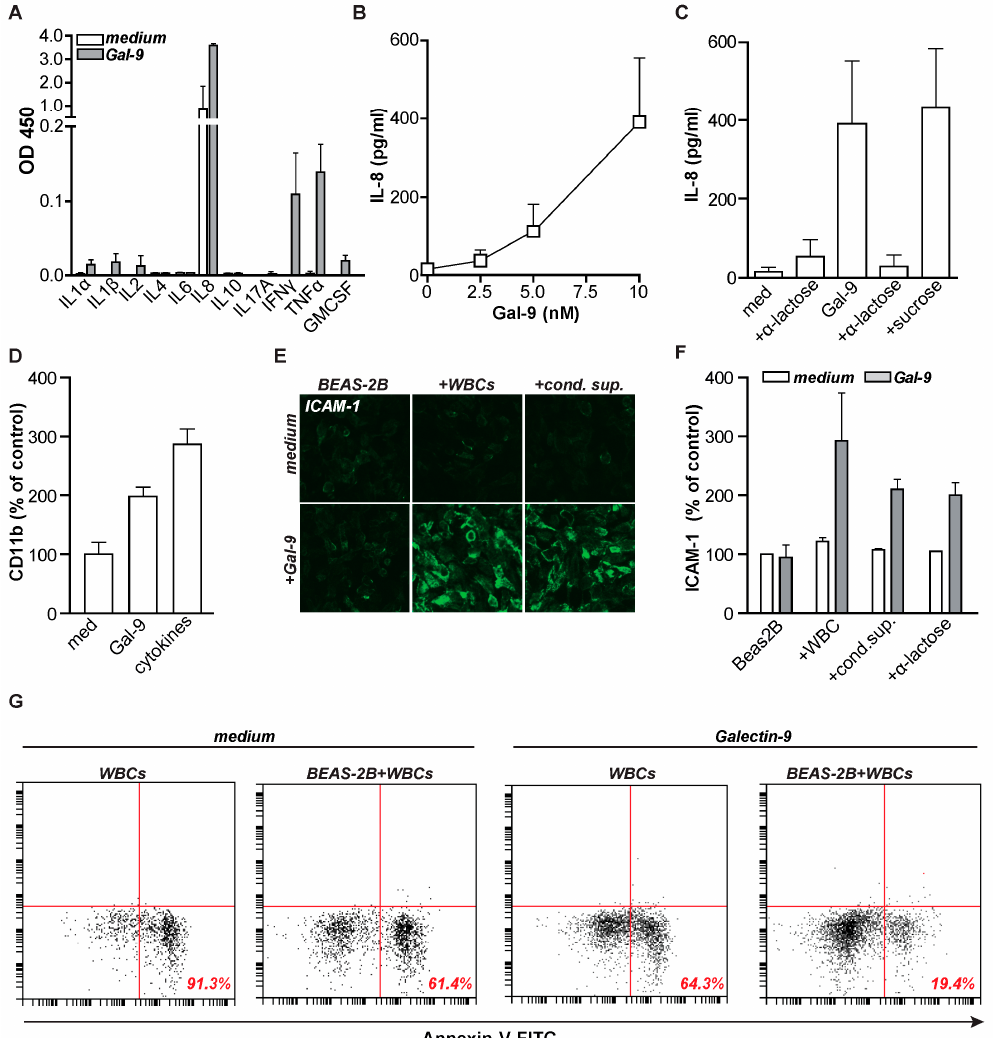
Figure 4. Gal-9 induces pro-inflammatory cytokines which induce Intercellular adhesion molecule 1 (ICAM-1) expression. ( A ) Screen for cytokines in supernatants of white blood cells (WBCs) after 16 h Gal-9 treatment (10 nM) using a multi-analyte ELISA. ( B ) IL-8 / CXCXL8 ELISA in the supernatants of WBCs treated with increasing concentrations of Gal-9. ( C ) ELISA to determine IL-8 concentrations in the supernatants of WBCs treated with 10 nM Gal-9 +/ − α -lactose (40 mM). ( D ) CD11b expression on granulocytes after 16 h Gal-9 treatment (10 nM) or a cytokine cocktail (400 pg / mL IL-8, 15 pg / mL TNF, 20 pg / mL IFN- γ ) containing the cytokines that are also induced by Gal-9 treatment. ( E ) Fluorescent pictures of ICAM-1 expression on Beas-2B cells after incubation with WBCs +/ − Gal-9 (10 nM) or conditioned supernatant harvested from medium- or Gal-9-treated WBCs. Magnification × 20 ( F ) As in ( E ), measuring ICAM-1 expression by flow cytometry. ( G ) Granulocyte viability measured by Annexin-V-FITC in the presence or absence of Beas-2B when treated with medium or Gal-9 (10 nM). All experiments were at least performed in triplicate.